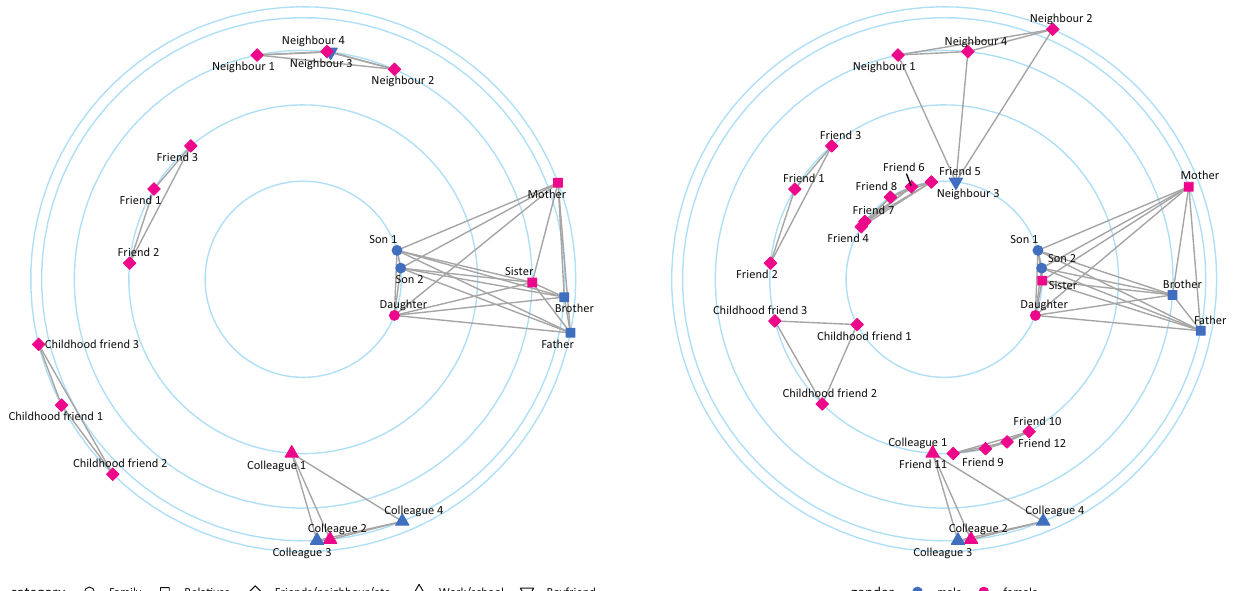
Figure 1. Louise’s personal networks, representing the people who were around here before and after she called the police. in redefining her relationship with her partner as abu‐ sive. Nicole had been with the perpetrator for four years, and they had children together. The violence started in the final year of the relationship, and Nicole confided in one of her sisters while she did not initially disclose the abuse to the rest of the family. However, her mother and brother suspected it, and her sister‐in‐law gave her the number of a service for abused women. Nicole con‐ tacted the service, who strongly advised her to call the police: During a violent episode, Nicole remembered the words of the woman from the service and decided to call the police. After she filed a police report, the whole family consistently supported her in leaving the perpe‐ trator’s house and finding a permanent home for herself and the